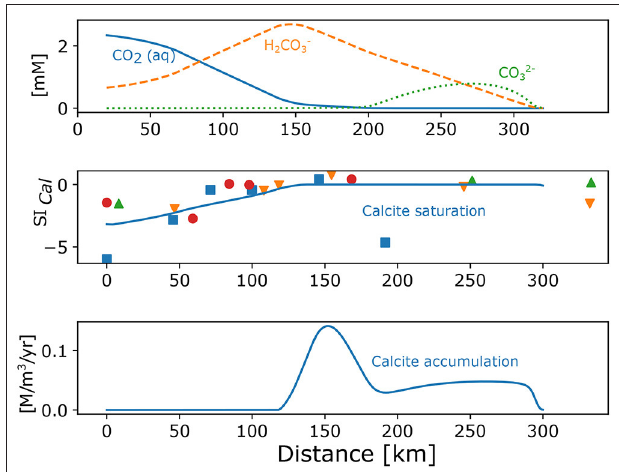
FIGURE 3 | Modelled concentrations of dissolved carbonate species (upper) , saturation index (SI) for calcite (line, middle), and rate of calcite accumulation in a function of distance (lower) . SI calculated with PHREEQC (Parkhurst and Appelo, 1999 ) from the observations is also shown (points, middle ). Input parameters for the model are: Rech_0 = 0.0025, Rech_50 = 0.0002, Kx = 0.33, Kz = 0.033, pCO2 = –1.5, log r_Plag = –17.22, log K Cal = -8.48, n = 0.22, CEC = 2.5. Different symbols for measured data indicate separate flow paths.